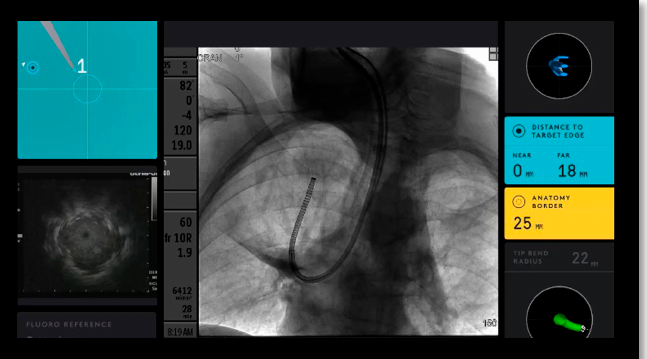
Figure 3. Upper left blue ball represents the target. Bottom left intergraded EBUS view. Center Fluoroscopy view of catheter with tool extension. Right Informational screen displaying distance to virtual target, anatomy borders, orientation guide, and catheter tip bend radius.